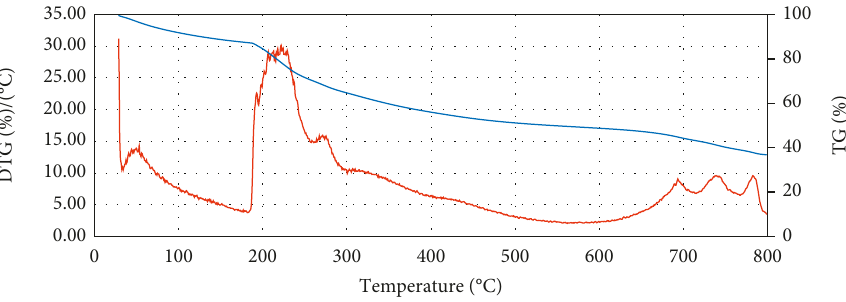
Figure 9: TGA curve and DTG curve for Eucheuma cottoni